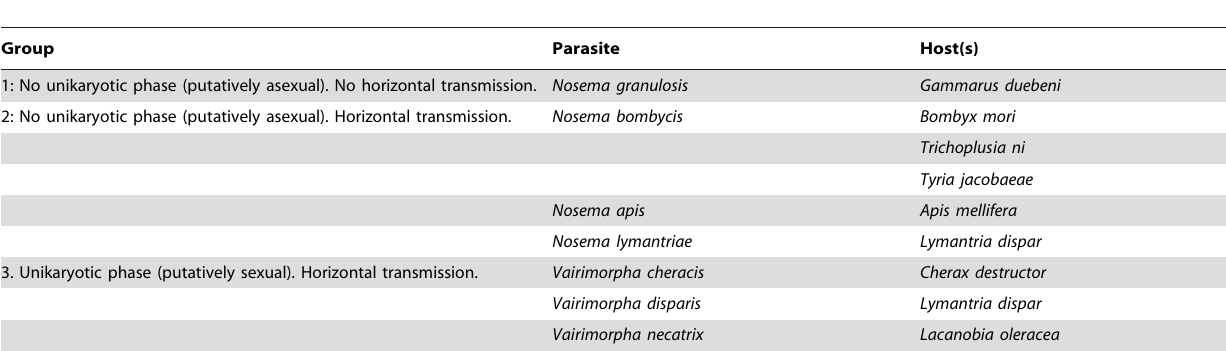
Table 1. Assignment of Nosema species to life cycle groups based on transmission and sexuality.